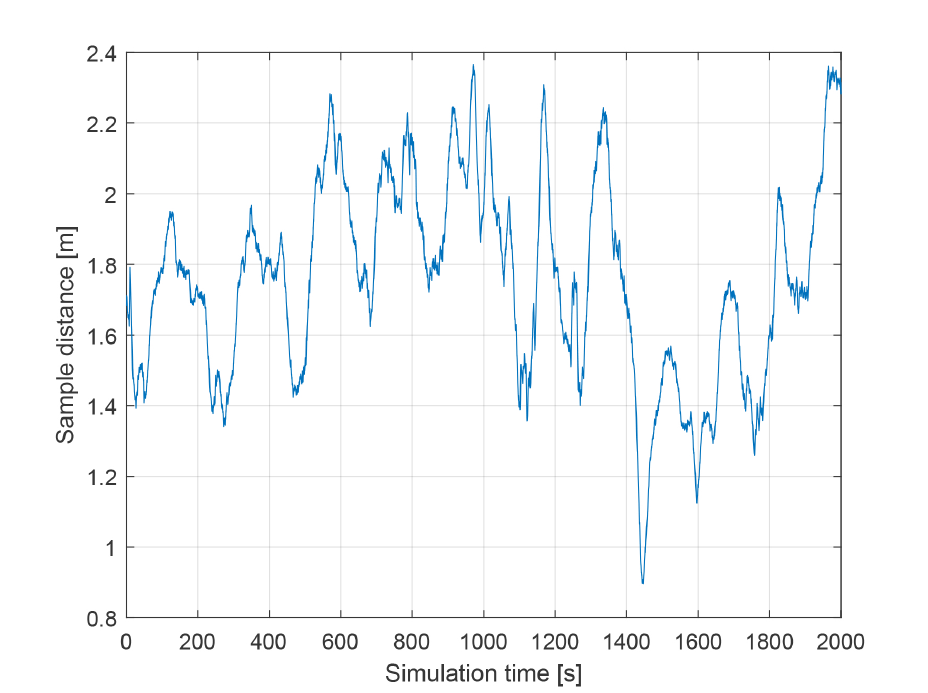
Figure 8. Sample distance as a function of simulation time. Apart from the drift, base images and template images from each cycle wew also logged. One of the TM cycles was merged into one picture and presented in Figure